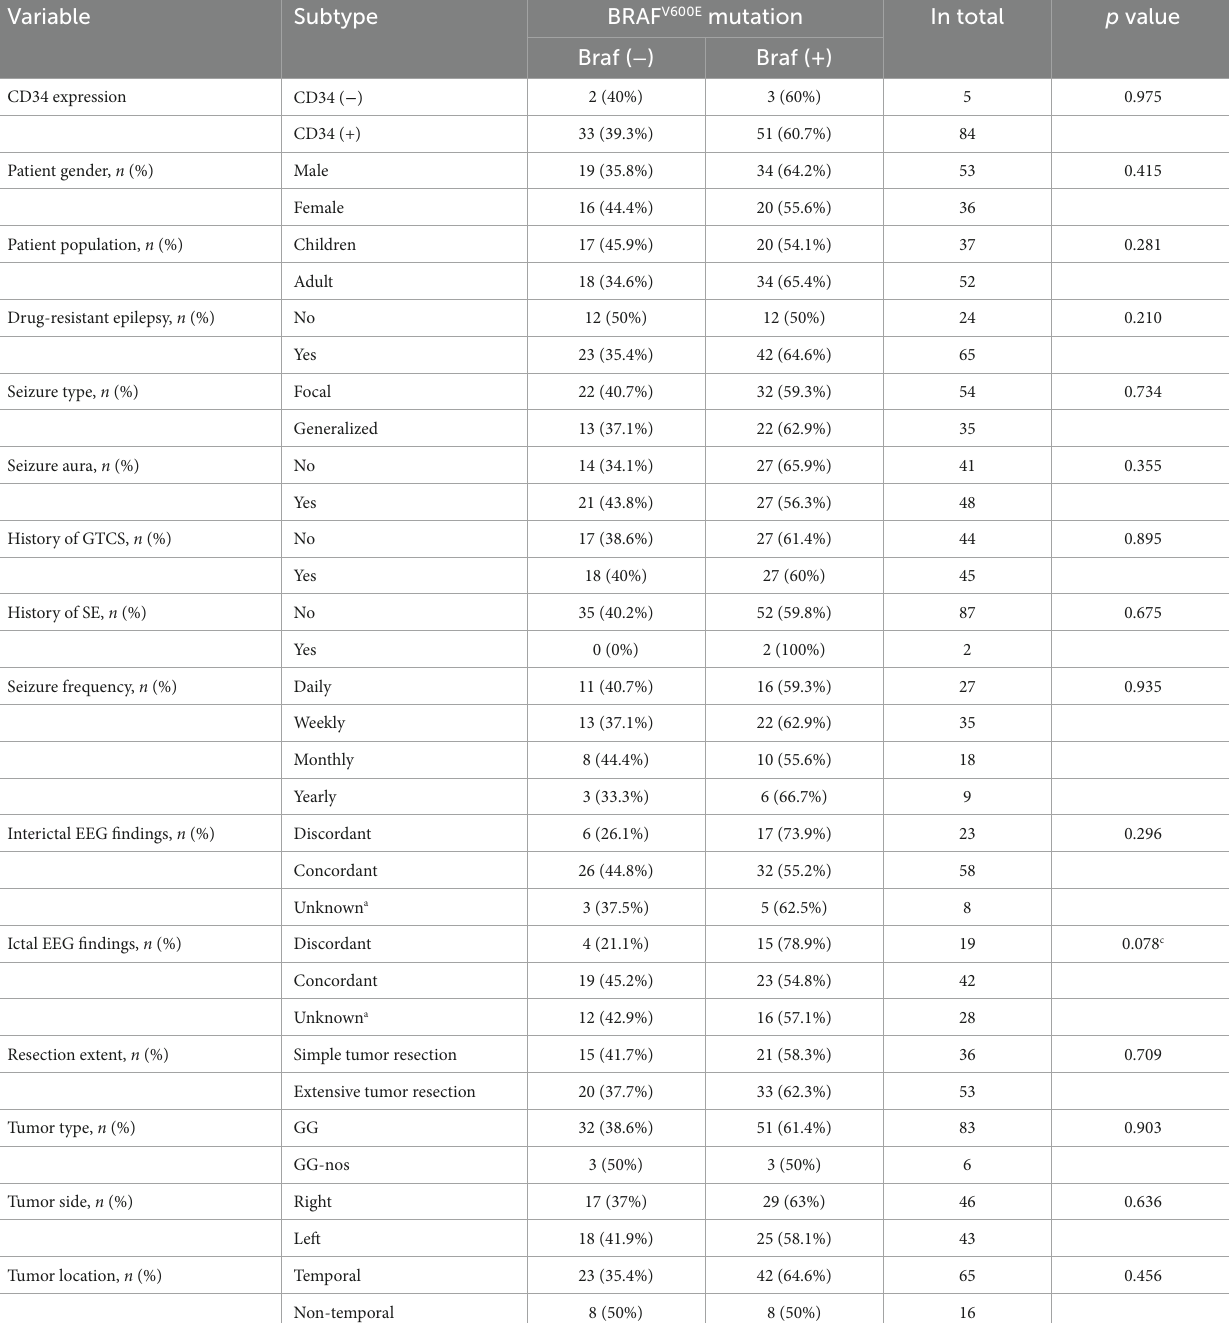
TABLE 3 Univariate analysis of the relationships between BRAF V600E mutation in GG and clinicopathology in 89 patients. Variable Subtype BRAF V600E mutation In total p value Braf ( − ) Braf (+) CD34 expression